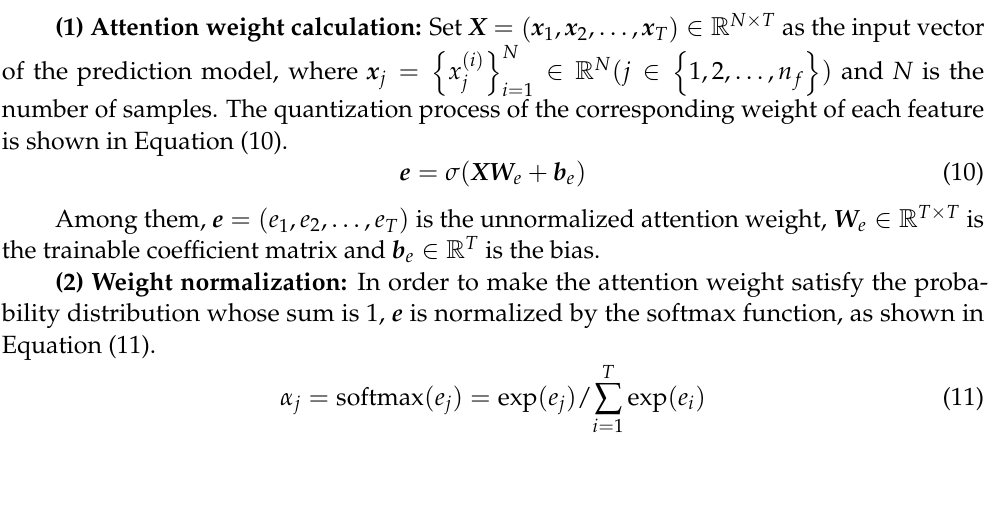
Figure 3. Feature attention mechanism.